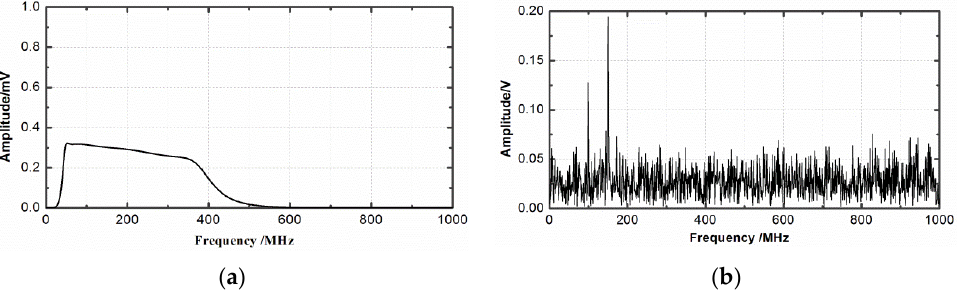
Figure 4. Frequency analysis of the simulated PD signal: ( a ) with noise; ( b ) without noise.